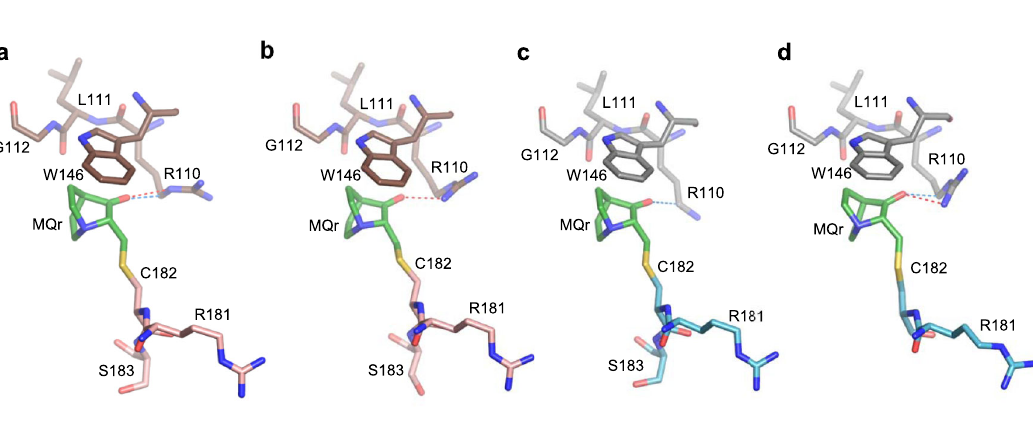
Fig. 1 MQ bound to C182 in R273H and R273C mutants. The MQ-C182 conjugates and interactions with neighboring molecules are from the following crystal structures. a R273H-MQ (I), monomer B and symmetry-related monomer C. b R273H-MQ (II), monomer B and symmetry-related monomer C. c R273C-MQ (I), monomer B and symmetry-related monomer C. d R273C-MQ (II), monomer C and symmetry-related monomer B. All MQ-C182 conjugates interact with neighboring molecules via stacking interactions with W146, hydrogen bonds and CH···O interactions with R110 side chains. The missing side chains or atoms are disordered and not well de fi ned. The structures are in stick representation with the following color codes: C atoms are shown in green for MQ, pink and brown for the MQ-modi fi ed and neighboring monomers, respectively, of R273H-MQ (I, II), and light blue and grey for the corresponding monomers of R273C-MQ (I, II). N, O and S atoms are in blue, red and yellow, respectively. Hydrogen bonds and CH···O interactions are indicated by red and blue dotted lines, (I) (Table 1). Bound MQs is observed in monomer A, and both enantiomers (with partial occupancy) in monomer D of R273H- MQ (I) (Fig. 3a, b, respectively). These conjugates form several